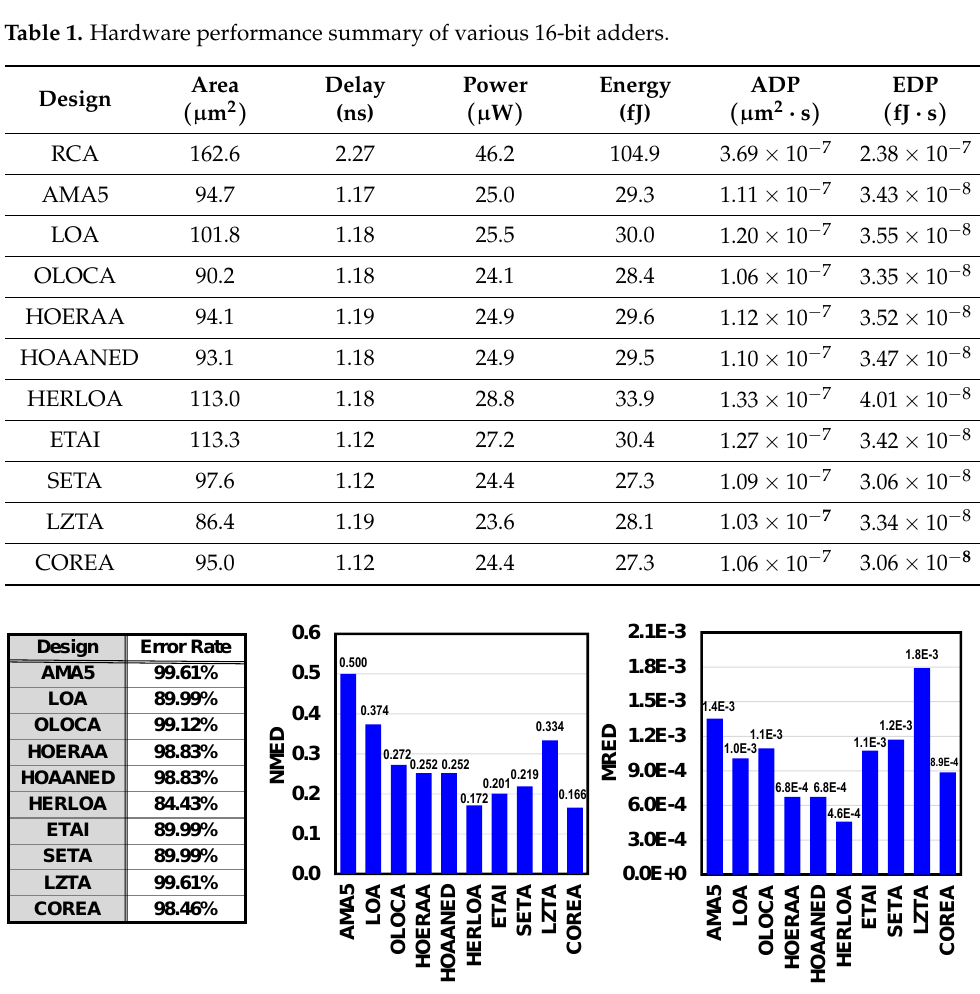
Figure 4. Comparisons of error rate, normalized mean error distance (NMED), and mean relative error distance (MRED) of approximate